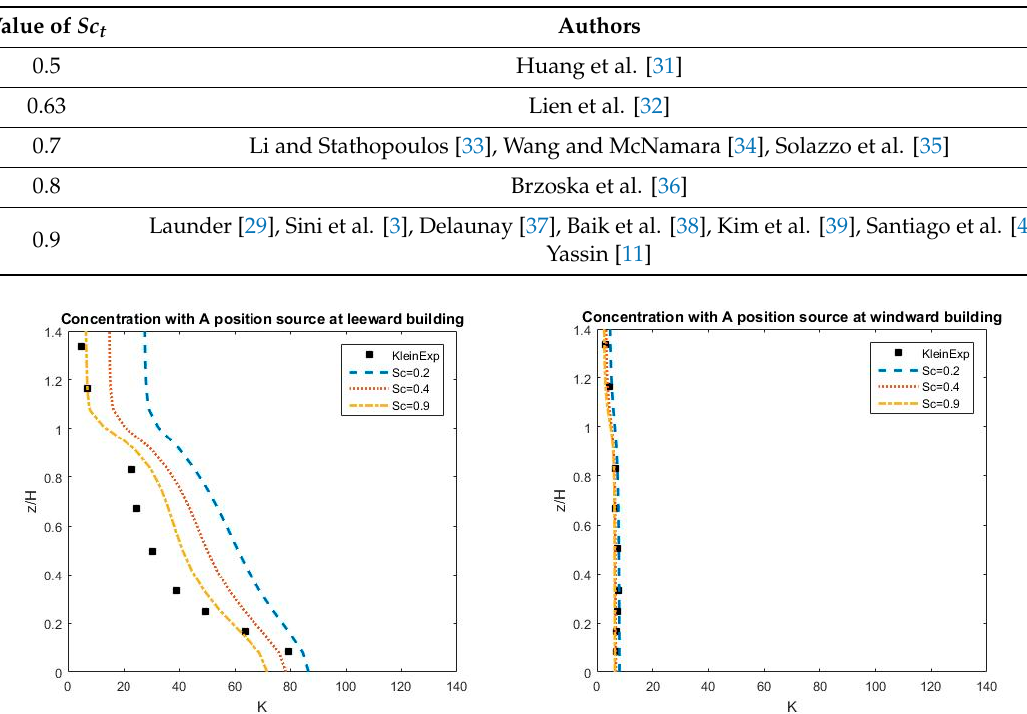
Figure 4. A validation of the Schmidt number against Kastner-Klein’s experiment [40].